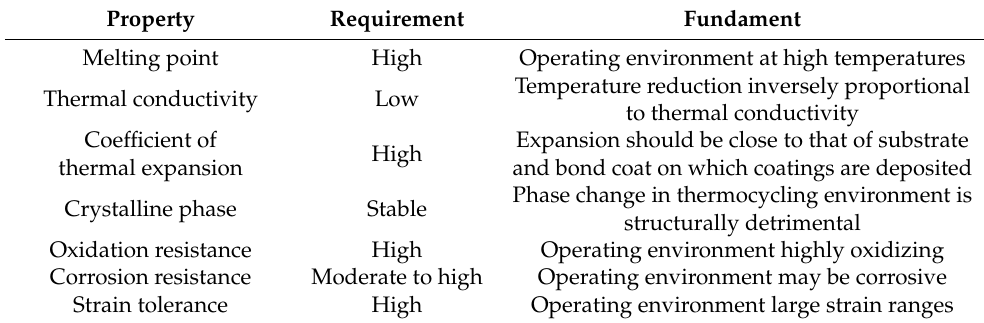
Table 1. Material requirements for the ceramic top coat of thermal barrier coatings [70]. Property Requirement Fundament Melting point High Operating environment at high temperatures Thermal conductivity Low Expansion should be close to that of substrate High and bond coat on which coatings are